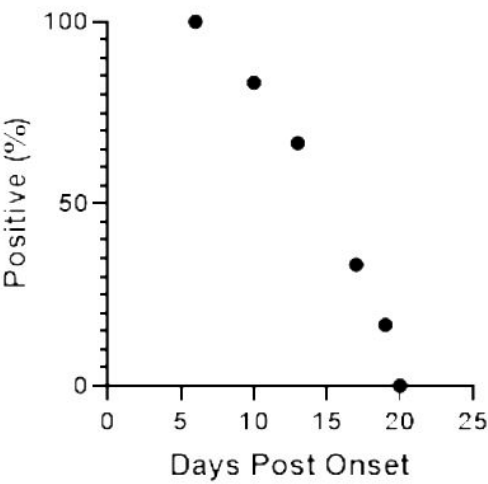
Figure 3. Viruria detected over time for urine collected from 2018 cohort participants with confirmed WNV infection.